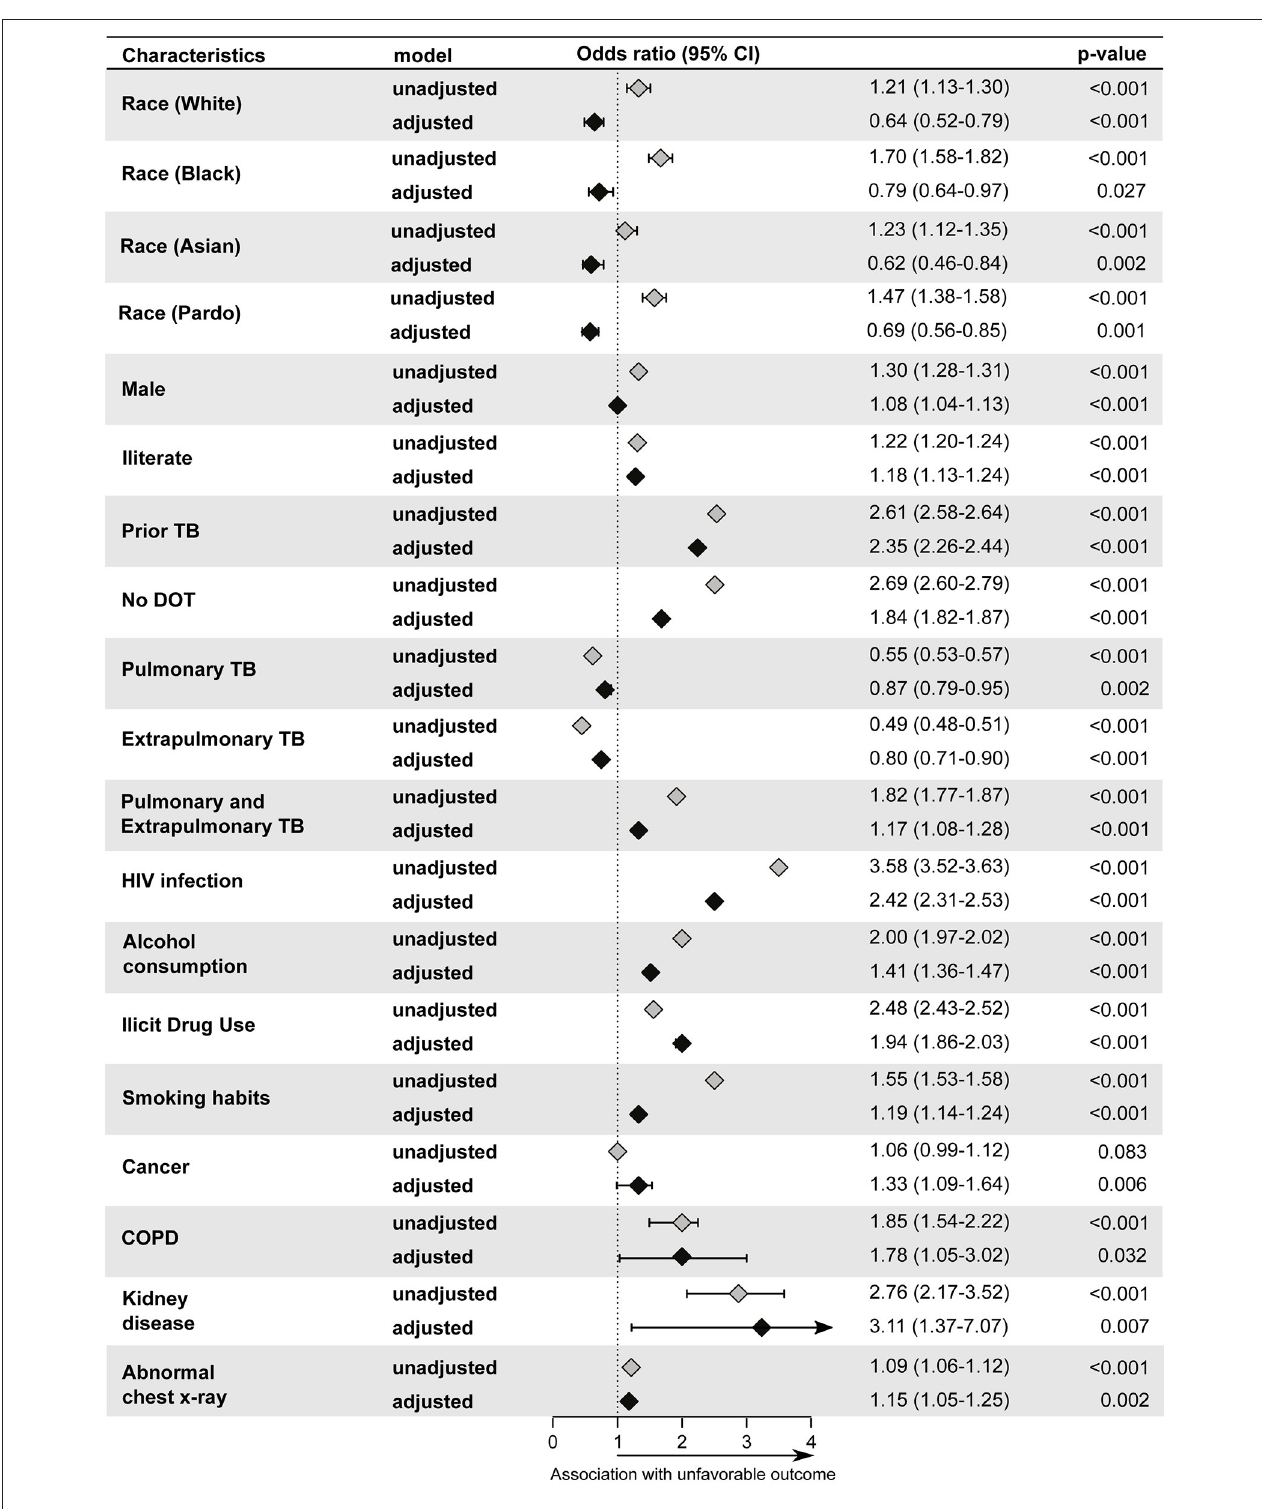
FIGURE 5 | Backward stepwise logistic regression model test independent associations between all the relevant clinical and epidemiological parameters and treatment outcome in adult group (25–64). The unfavorable outcome was used as reference to test associations. Only parameters which remained with p < 0.05 in in the adjusted model (95%CI: 95% confidence interval) were plotted. Adjustment was performed for each parameter: race (reference: indigenous); male (reference: female); illiterate(reference: literate); prior TB (reference: new case); no DOT (reference: DOT indication).Pulmonary TB (reference: Pulmonary and Extrapulmonary TB); Extrapulmonary TB (Reference: Pulmonary and Extrapulmonary TB); Pulmonary and Extrapulmonary TB (reference: Pulmonary TB); HIV infection (reference: without